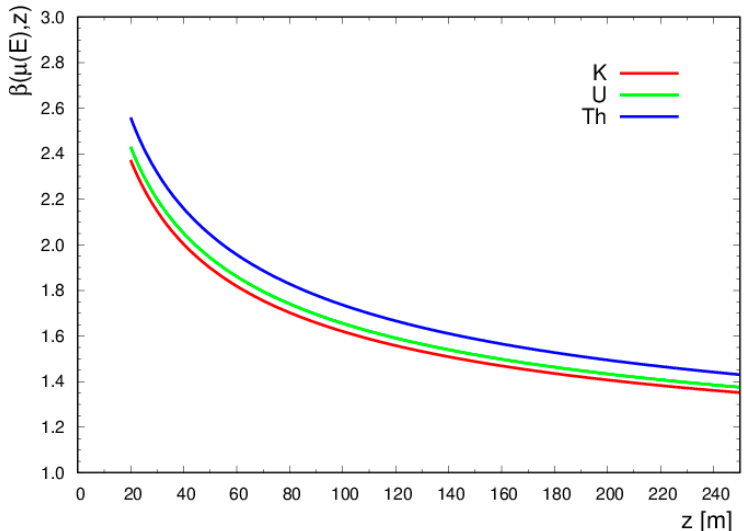
Figure A1. Plot of the β(μ(E), z) factor as function of the survey altitude z : the red, green and blue line refer respectively to the 40 K, 214 Bi ( 238 U) and 208 Tl ( 232 Th) gamma emission energies.